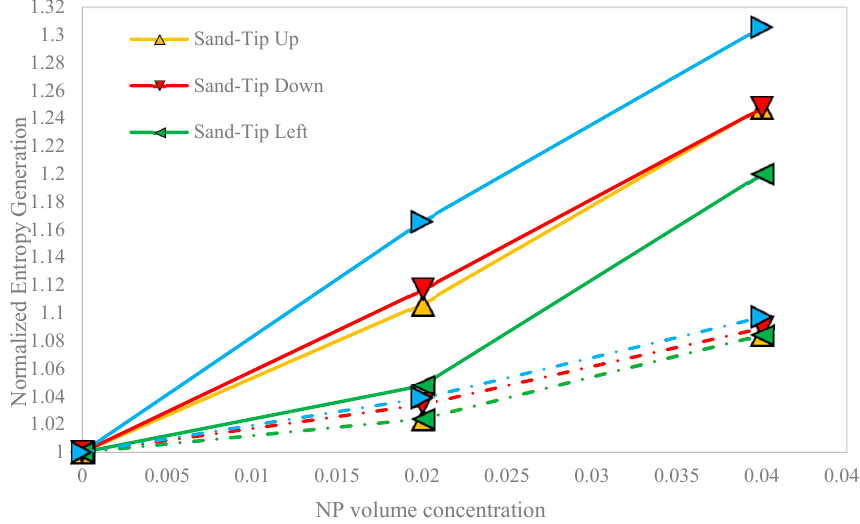
Figure 13. Normalized entropy generation against the NP volume concentration, in all cases.